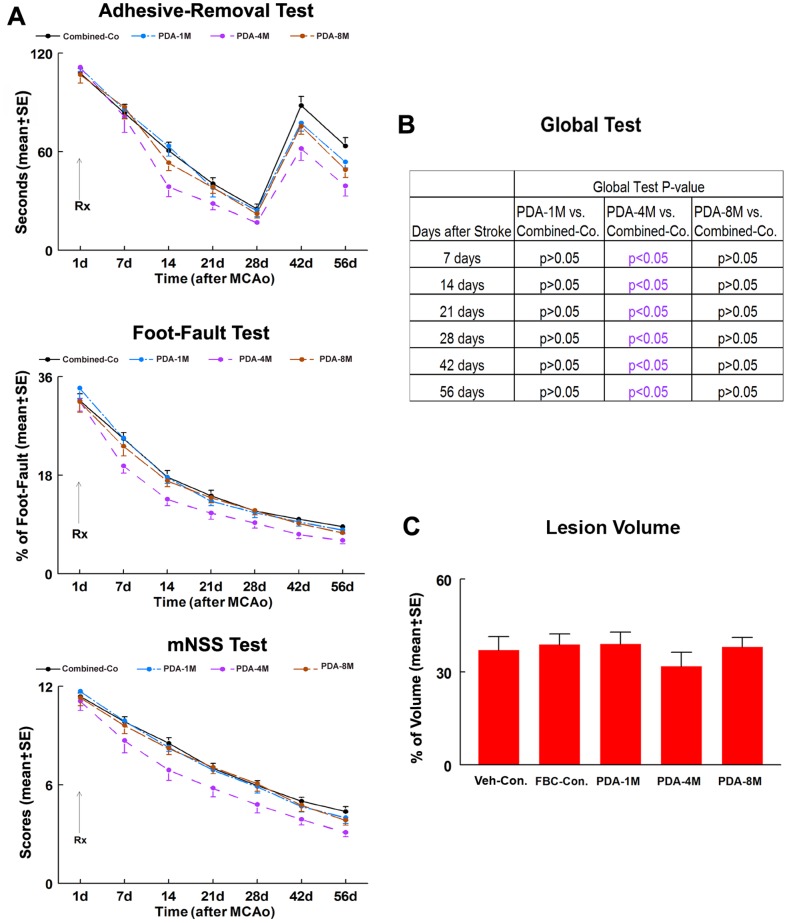
Neurological outcome and lesion volume in young adult rats.Panel A shows adhesive-removal, foot-fault and mNSS tests after stroke in the 4 young adult rats experimental groups (combined-control, 1×106, 4×106, and 8×106 PDA-001 treatment groups). Panel B shows the global test analysis to detect the differences in functional recovery among the 4 groups. Panel C shows the lesion volume in the 5 young adult rats experimental groups. Error bars represent standard error of the mean (mean±SE).